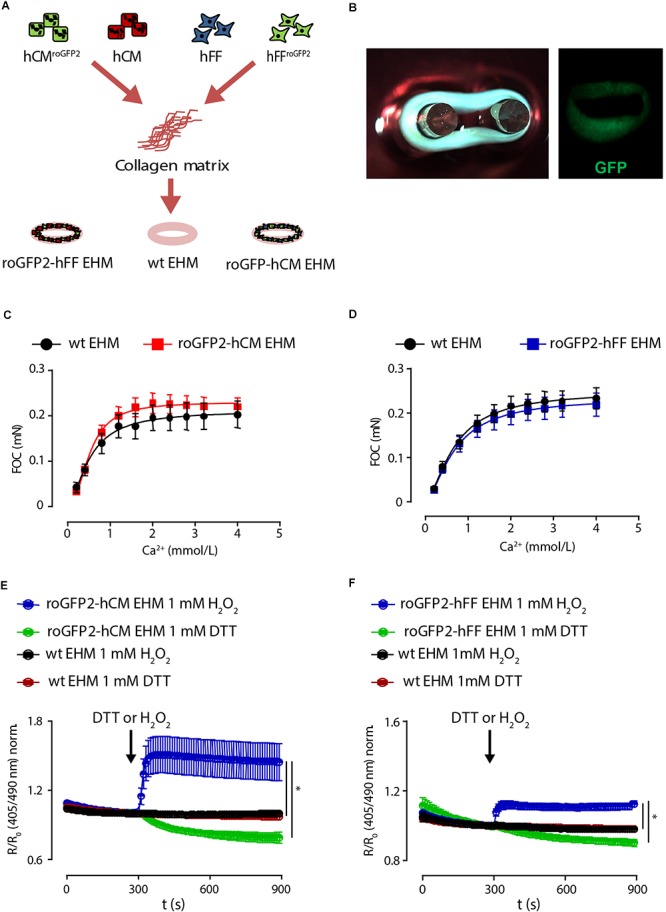
Cell type specific imaging of Grx1-roGFP2 in EHM. (A) EHM were constructed from defined mixtures of genetically naïve and Grx1-roGFP2 expressing hCM or hFF in a collagen hydrogel to create tissue for cell type specific redox potential imaging. (B) Photograph and fluorescence image of EHM expressing Grx1-roGFP2 (GFP). Analysis of force of contraction (FOC) under isometric conditions and electrical field stimulation (1.5 Hz); maximal inotropic capacity was evaluated under increasing extracellular calcium concentrations: (C) EHM composed of Grx1-roGFP2 and genetically naïve (wt: wild type) hCM with genetically naïve hFF (n = 17/33); (D) EHM composed of Grx1-roGFP2 and genetically naïve (wt: wild type) hFF with genetically naïve hCM (n = 36/42). Change of roGFP2 fluorescence signal in EHM with Grx1-roGFP2 expressing hCM (E) and hFF (F) as a function of time under oxidation by H2O2 (1 mmol/L) and reduction by DTT (1 mmol/L).